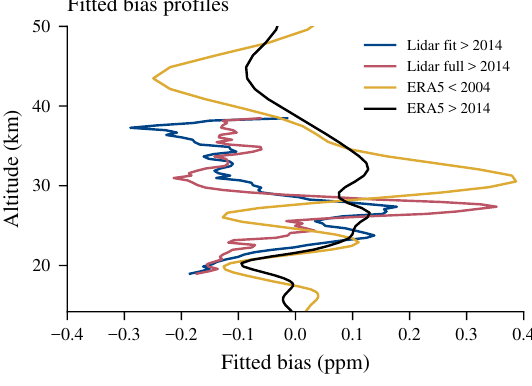
Figure 3. Bias profiles as estimated by the KIT regression for lidar and ERA5 data. The lidar bias compares to data before 2014, whereas the data block from 2004 to 2015 is the reference for ERA5